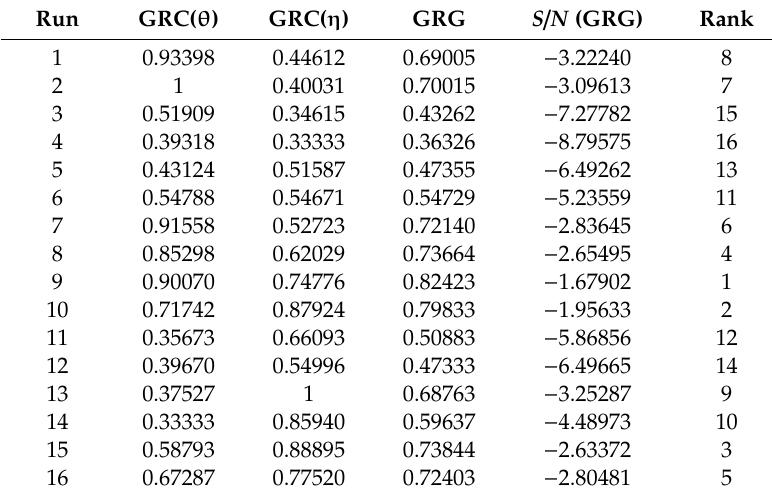
Table 7. Grey relational coe ffi cient (GRC) of flatness ratio and cladding e ffi ciency, grey relational grade (GRG), S / N conversion of GRG for each run.